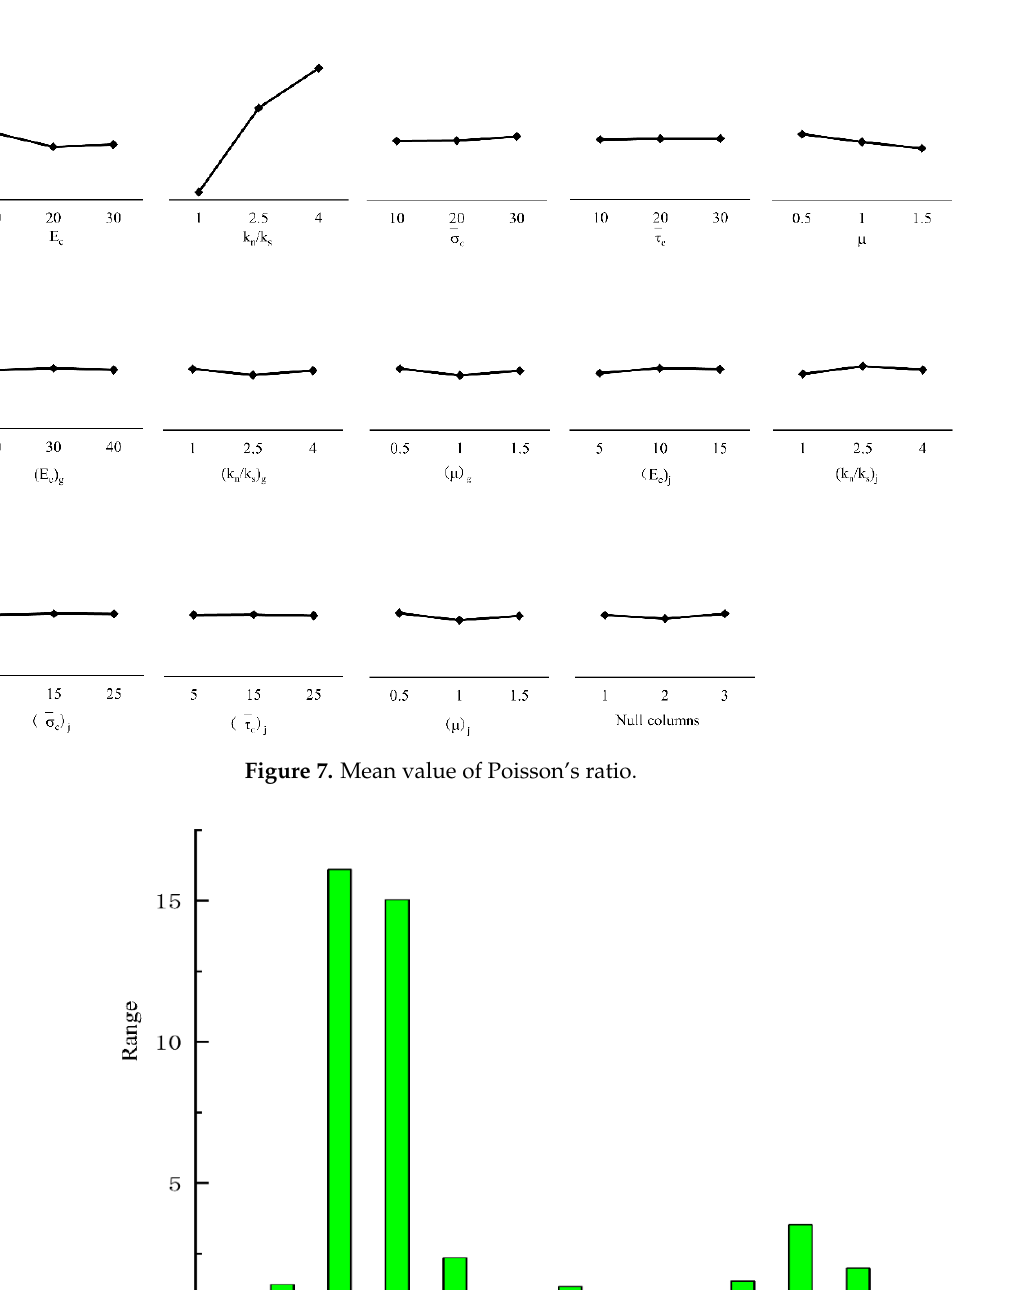
Figure 6. Mean modulus of elasticity.